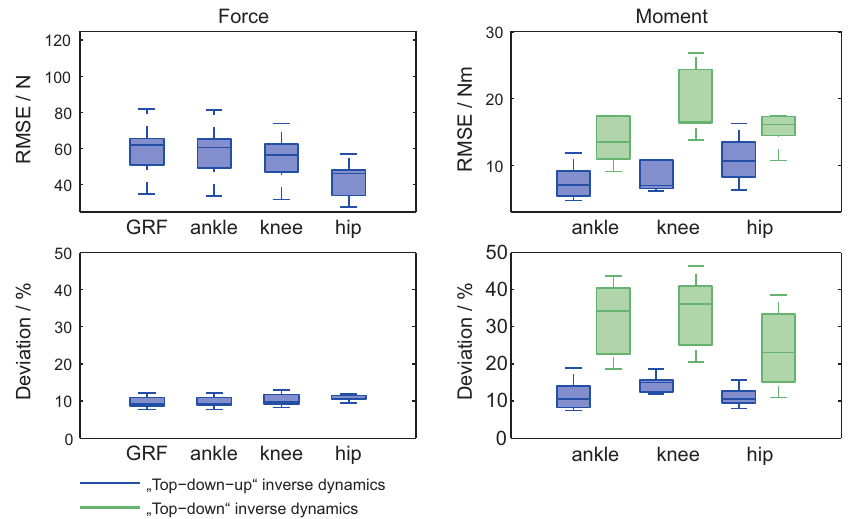
Figure 6. RMSE and calculated deviation for joint forces, GRF and joint moments for top-down-up and top-down inverse dynamics based on the reference value. Measurements were performed in the laboratory on a force platform. The middle line, the bottom and the top of the box present the median, 25th and 75th percentiles, respectively. The whiskers present the furthermost value in the 1.5 interquartile